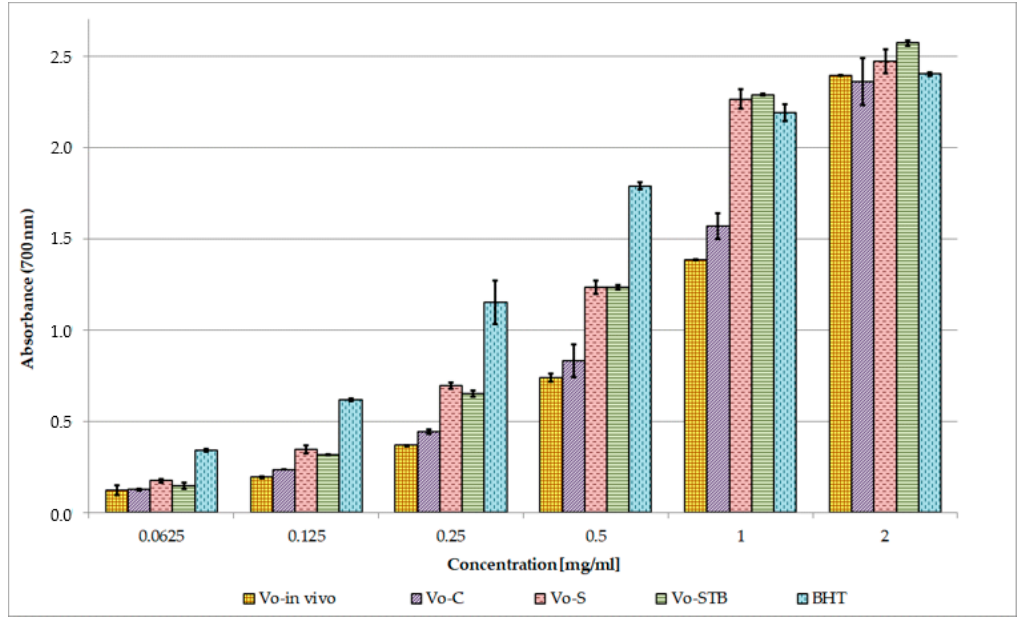
Figure 6. Reducing power of V. officinalis extracts. Values are expressed as the mean ± SD (n = 3). Vo - in vivo —V. officinalis parent plant grown in vivo-herb extract; Vo- C— V. officinalis callus culture extract; Vo -S— V. officinalis suspension culture extract; Vo- STB— V. officinalis stirred-tank bioreactor culture extract; BHT—butylated hydroxytoluene.